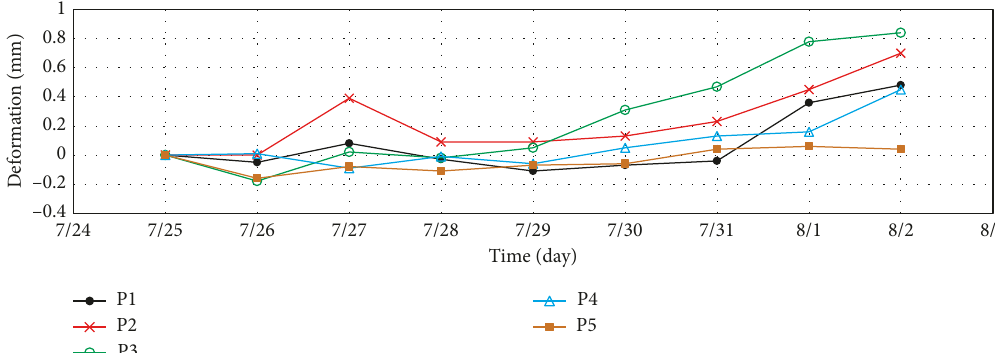
Figure 20: Temporal process curves at the five points at the top of the dam obtained using the inverted plumb line method. Table 4: GB-SAR/inverted observation point deformation characteristic value statistics of dam crest. GB-SAR (inverted plumb points)